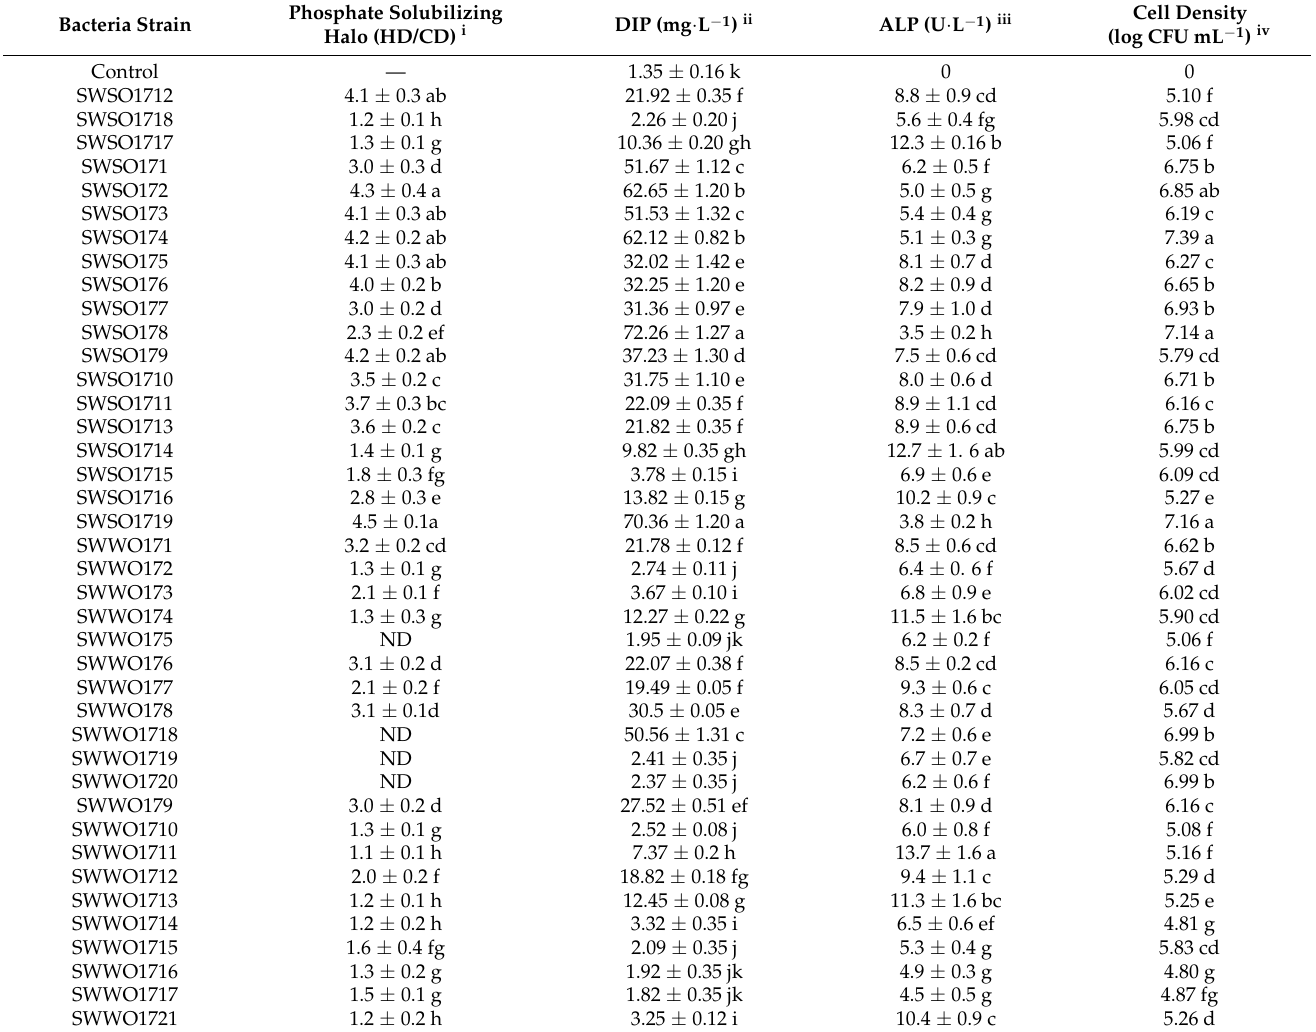
Table 2. Solubilizing characteristics of the 39 OPB strains in the sediments of the Sancha Lake. In the same column, data with different letters, such as a, b, and c, indicate significant differences, while data with the same letter indicated insignificant differences at 0.05 level. Data with letters such as ab were insignificantly different from both data with letter a and data with letter